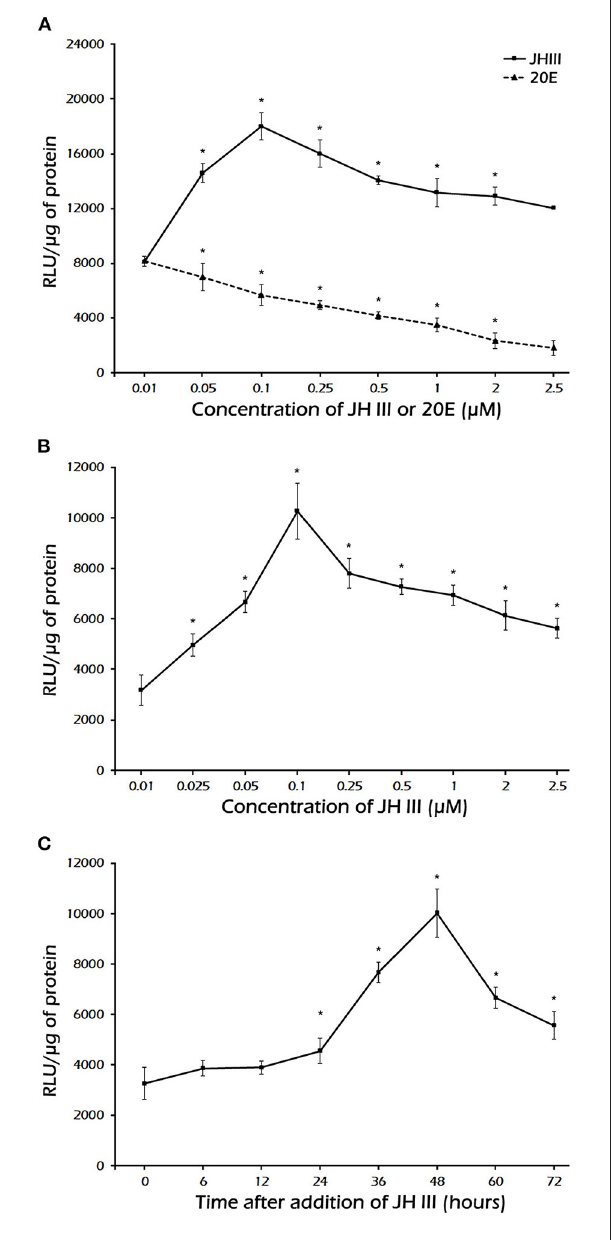
FIGURE 4 | (A) Dose-response induction by JH III and inhibition by 20E of luciferase expression under the control of the Vg2 full-length promoter. (B) Dose-response induction of luciferase expression under the minimal promoter length − 204 bp. (C) Time course of JH III-mediated induction of luciferase expression under the control of a minimal promoter length − 204 bp. The values are presented as the mean ± SD ( n = 3). In these experiments, Sf 9 cells were transfected with the pGL3 vector containing the Vg2 promoter, cells were exposed to different concentrations of JH III or 20E, and luciferase activity was measured 48h after hormone addition. *Statistically significant at P <